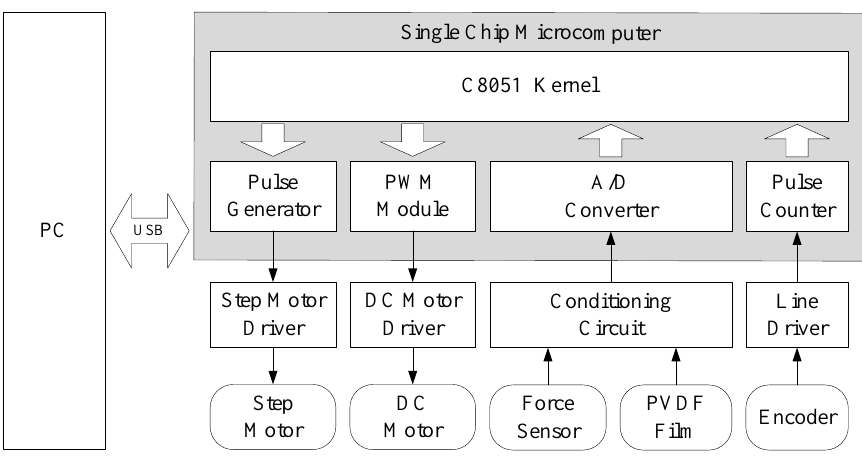
Figure 4. Circuit architecture of the measurement